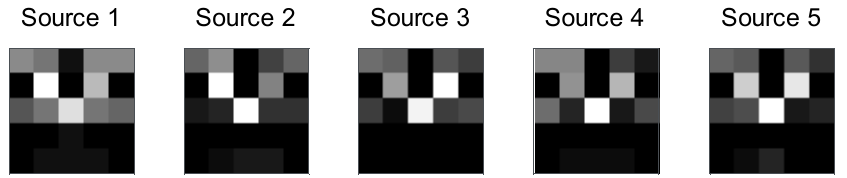
Figure 6. The first 5 out of 200 total images for the simple face example. Each image has 25 pixel values of various gray scale amounts.